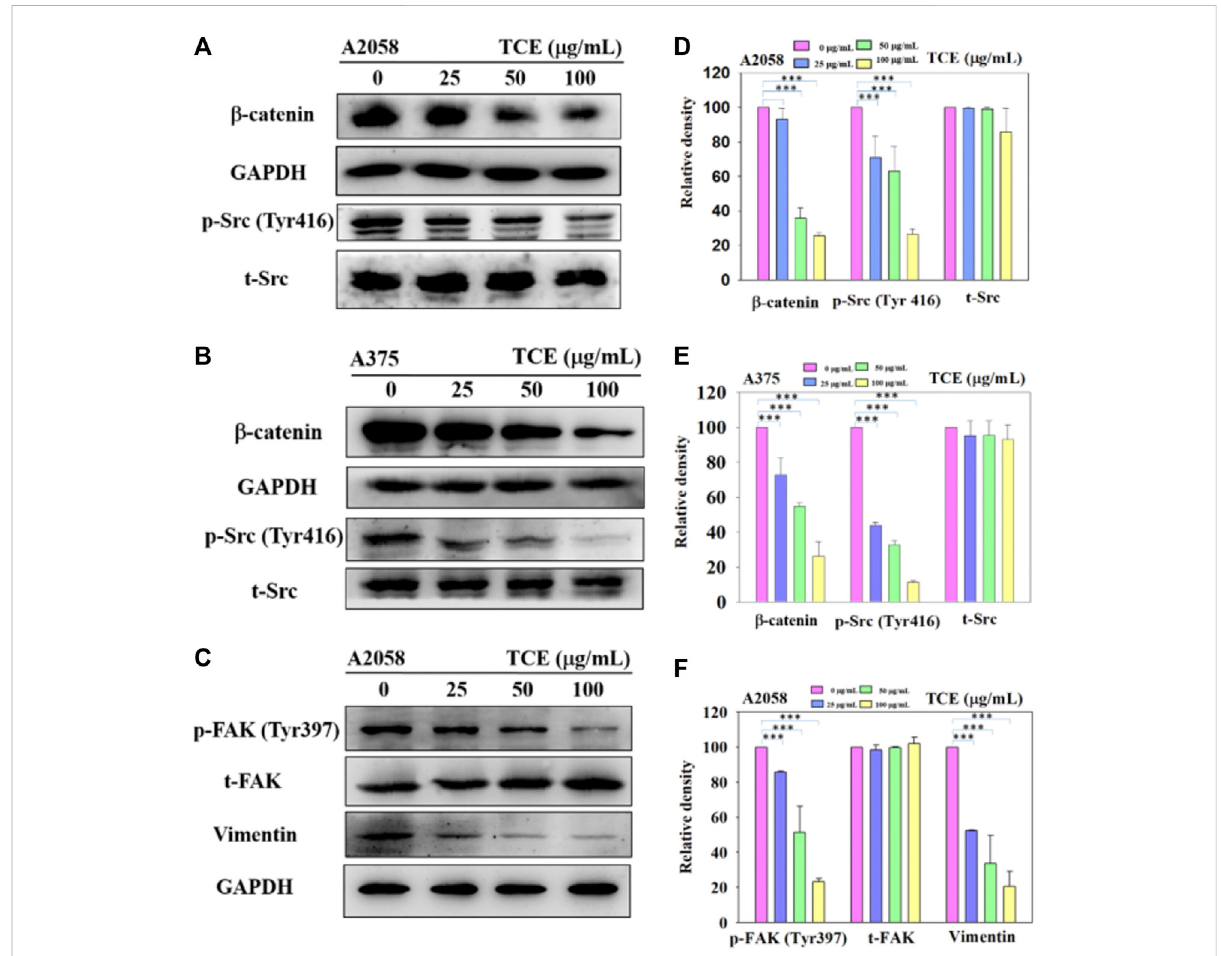
FIGURE 6 A2058 and A375 cell lines were pretreated with TCE and then incubated for 24 h. The cells lysates were subjected to SDS-PAGE followed by westernblotswithanti- β -catenin,anti-p-Src(Tyr416),anti-t-Src,anti-GAPDH (A , B) andanti-Vimentin,anti-p-FAK(Tyr397),anti-t-FAK,anti-GAPDH forA2058 (C) ,asdescribedinMethodsSection2.8.Thebargraphshowsthestatisticalresultsofproteinexpression (D – F) .Thevaluesrepresentedthe means ± SD of at least three independent experiments. Comparisons were performed using two-way ANOVA with post hoc Turkey ’ s test (*** p <